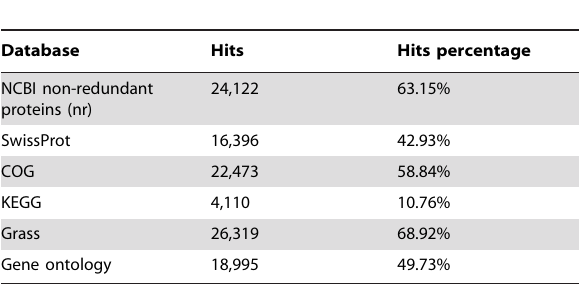
Table 2. Annotation summary of 38,192 P. maximum